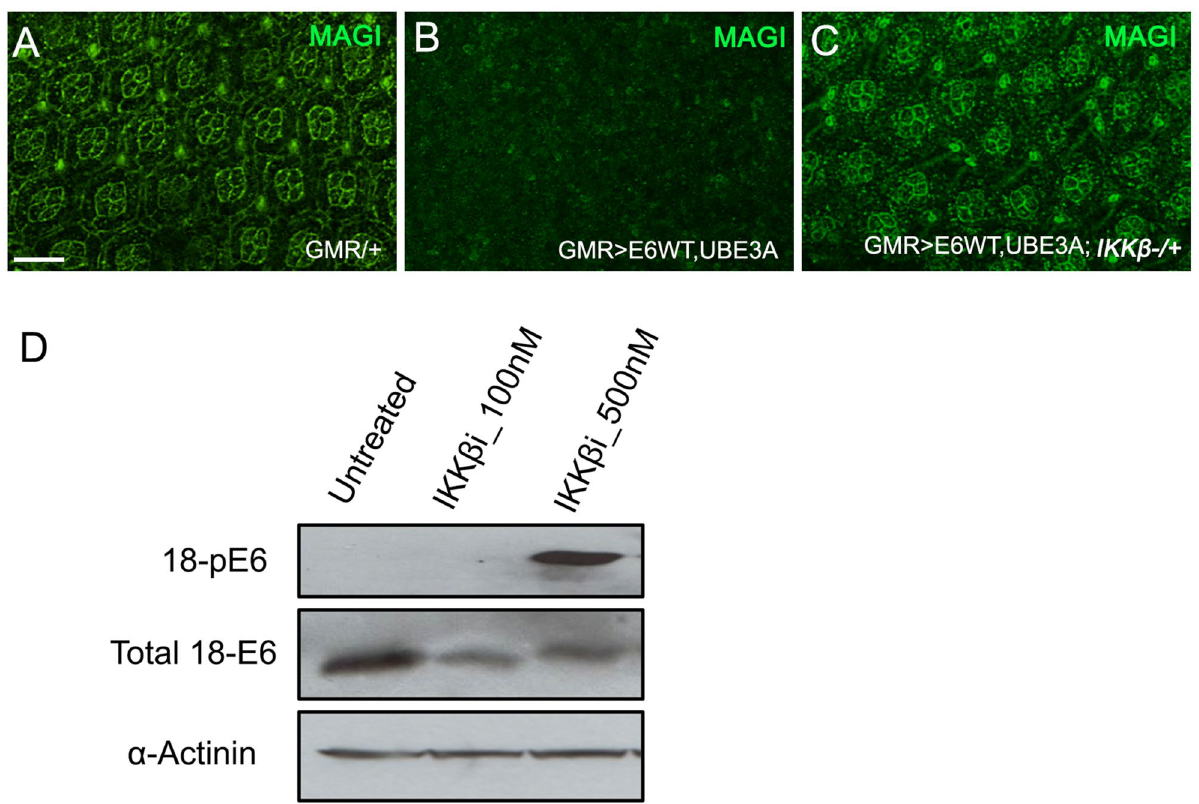
Figure 4. Reduced activity of IKKβ causes hyperphosphorylation of E6 and suppression of E6 + UBE3A- mediated degradation of PDZ domain protein, Magi. ( A – C ) Pupal eyes showing Magi immunolabeling. ( B ) Co-expression of E6 + UBE3A results in loss of Magi from cone cells and pigment cells compared with ( A ) in which only the Gal4 driver is expressed. ( C ) A mutated copy of the IKKβ gene suppresses the E6 + UBE3A- mediated loss of Magi. ( D ) Western blot of HeLa cell extracts shows that inhibition of IKKβ using a concentration of 500 nM of the inhibitor IMD 0354 results in phosphorylation of E6; compare that to lack of E6 phosphorylation in HeLa cells grown with no inhibitor (untreated) or with a low concentration of 100 nM. Scale bar indicates 10 µm. Results shown in ( A – C ) are representative of those of 5 different flies. Result shown in ( D ) is a representative of n =